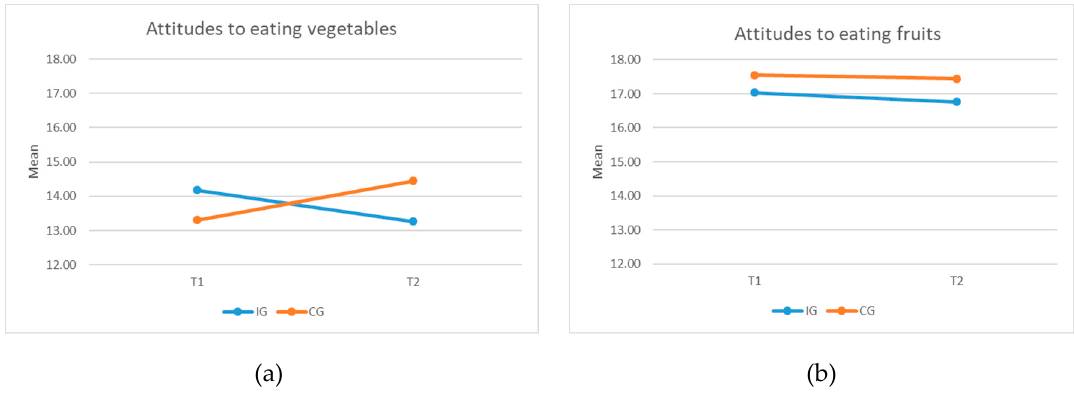
Figure 8. Attitude to eating (a) vegetables and (b) fruits.